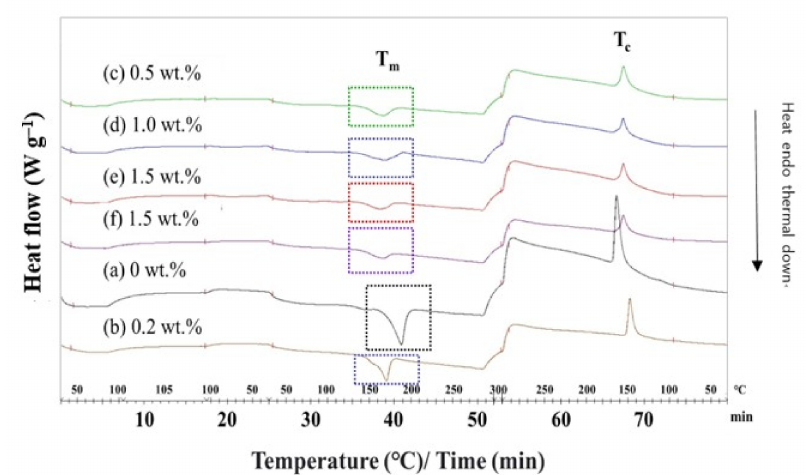
Figure 8. DSC thermal calorimetry scans of the PBT–EVOH polymer composite film.